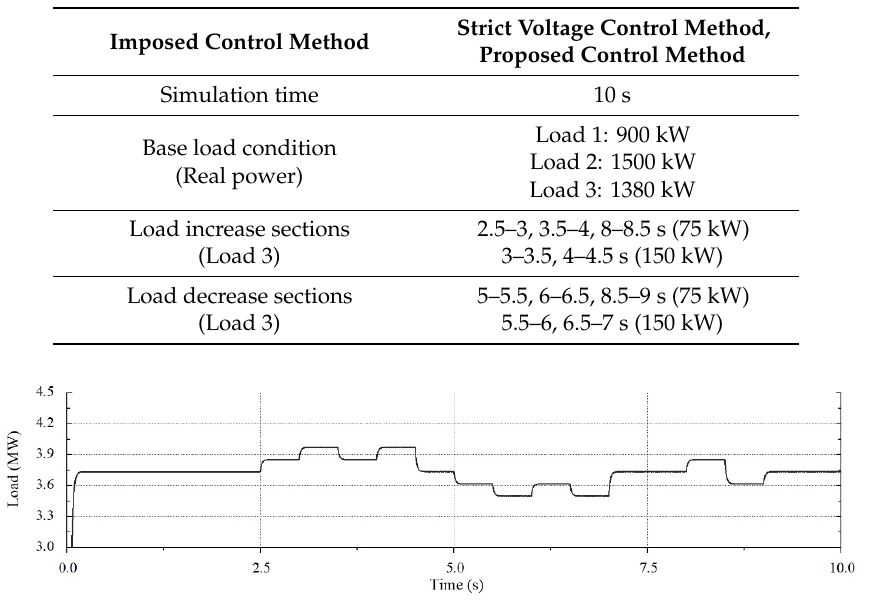
Figure 8. Simulated load variation in case study.